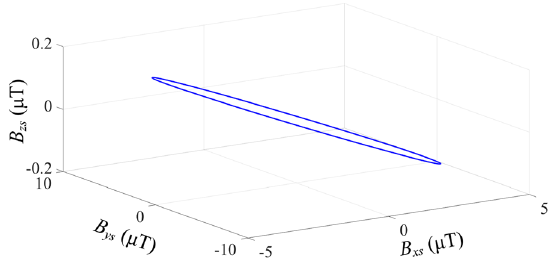
Fig. 11 Magnetic field trajectory in three-dimensional space